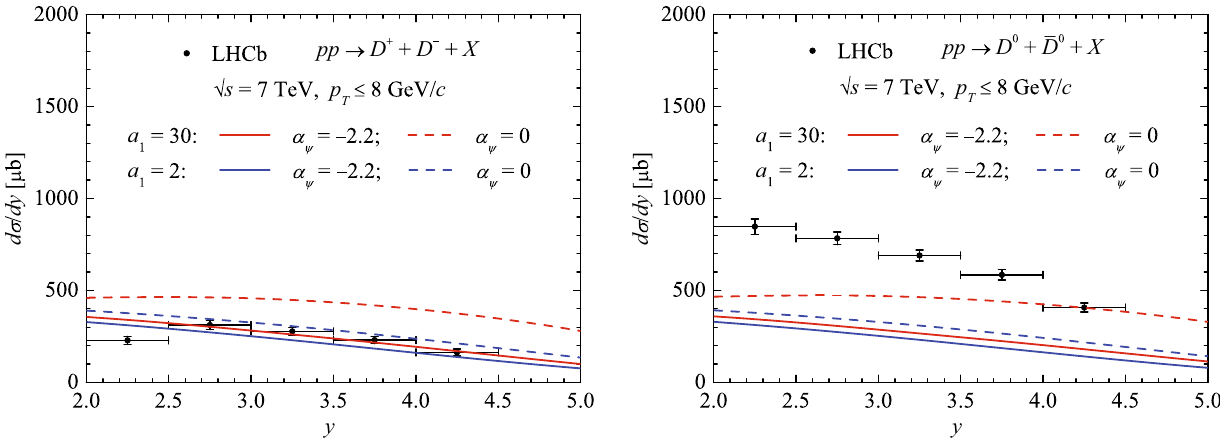
√ s = 7 TeV. Data are from the